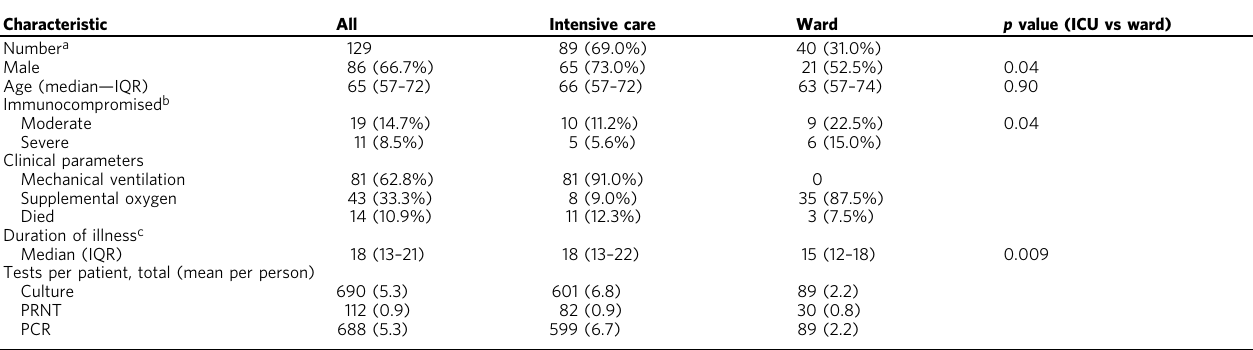
Table 1 Patient characteristics.